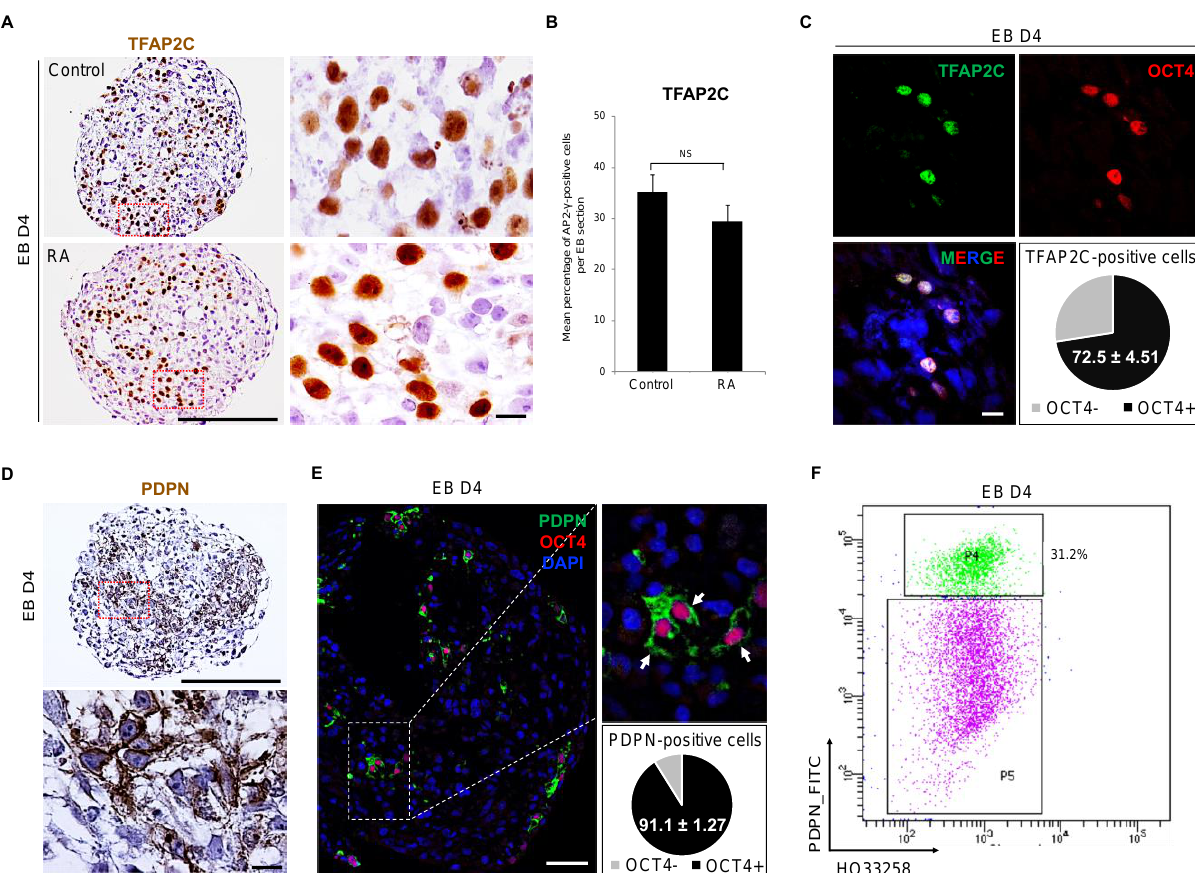
Figure 3. Detection of early hPGC protein markers in day 4 embryoid bodies. ( A ) Immunodetection of TFAP2C protein in a day 4 embryoid body in the absence (top row) or presence (bottom row) of RA. Scale bar, 200 µ m. The red dotted box of each condition is enlarged on the right image and corresponds to a × 1000 magnification. Scale bar, 10 µ m. ( B ) Percentages of TFAP2C-positive cells per embryoid body section at day 4. The results are presented as the mean ± sem., with n = 6 (Control or RA). ( C ) Confocal analyses of TFAP2C and OCT4 co-expression in PGC-LC. The pie chart shows the percentage of OCT4-positive cells within the TFAP2C-positive cells. The results are shown as the mean ± sem., with n = 4. ( D ) Immunodetection of the early hPGC surface marker PDPN in a day 4 embryoid body. Scale bar, 200 µ m. The red dotted box is enlarged on the right image and corresponds to a × 1000 magnification. Scale bar, 10 µ m. ( E ) Confocal analyses of PDPN and OCT4 co-expression in PGC-LC. The white dotted box is enlarged on the right image. Scale bar, 20 µ m. The pie chart shows the percentage of OCT4-positive cells within the PDPN-positive cells. The results are shown as the mean ± sem., with n = 4. ( F ) Dot plot analyses showing PDPN-positive PGC-LCs population from day 4 dissociated-embryoid bodies. P4 and P5 are the populations of cells considered as PDPN-positive and -negative, respectively. EB D4: Embryoid Body at Day 4; NS: Not statistically Significant; RA: Retinoic